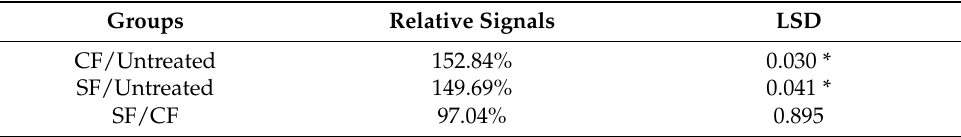
Figure 8. ( a ) Comparison of relative mean uric acid levels in real saliva samples after untreated, CF and SF. ( b ) Comparison of relative mean uric acid levels in real saliva samples with different treatments and assays: treated with CF and SF (left), treated with SF, and applying both the treatments (middle), and tested by the UAS and CS (right) (the error bars were obtained from the standard deviation of all previous measurements in the same category). * p < 0.05, § > 0.95. Table 1. Comparison of relative mean uric acid levels and LSD results in real saliva samples after untreated, CF and